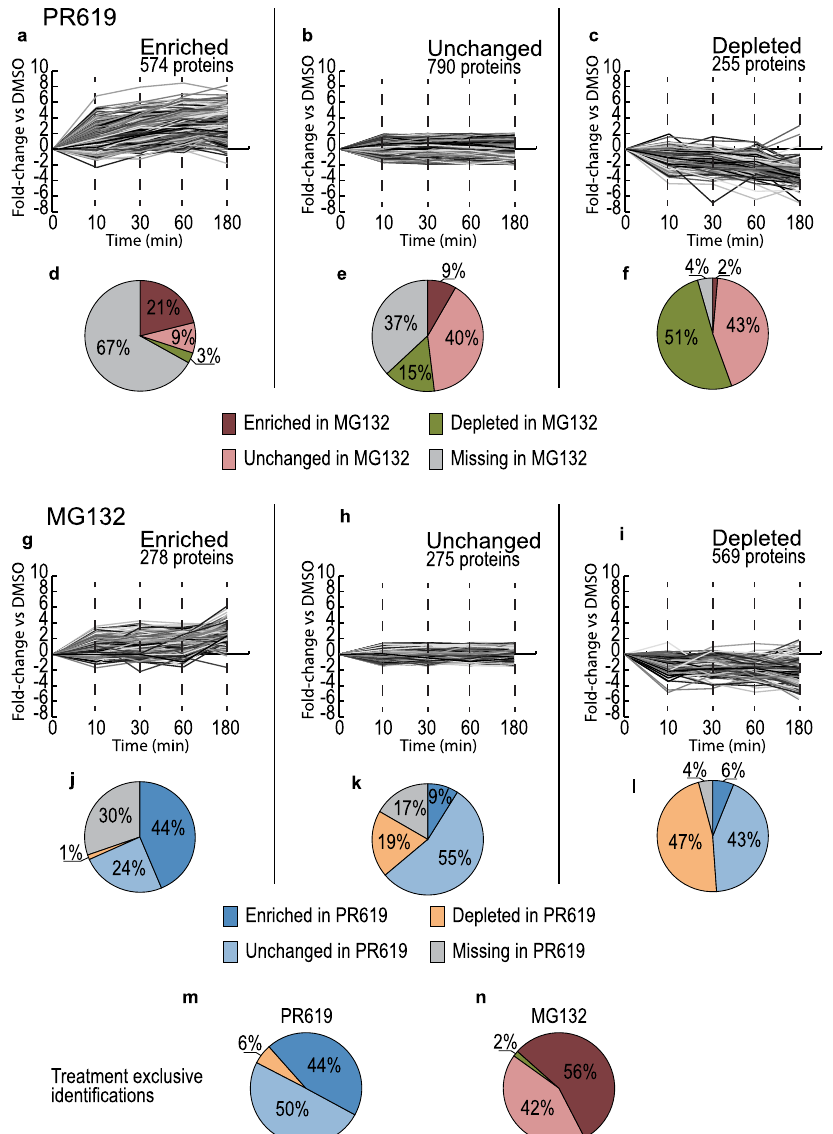
Fig. 3 Large pools of His10-Ub substrates exclusively identi fi ed in DUB or proteasome-inhibited samples. a – c Dynamics of His10-Ub substrates identi fi ed in PR619-treated samples grouped based on their fold-change vs DMSO (log2), “ Enriched ” (>twofold enrichment) ( a ), “ Unchanged ” (<twofold enrichment and <twofold depletion) ( b ) and “ Depleted ” (>twofold depletion) ( c ). d – f The His10-Ub groups in PR619-treated samples compared to their grouping in MG132 treated samples with PR619 “ Enriched ” group distribution in d , “ Unchanged ” group distribution in e and “ Depleted ” group distribution in f . g – i Dynamics of His10-Ub substrates identi fi ed in MG132 treated samples grouped according to the same criteria with groups “ Enriched ” ( g ), “ Unchanged ” ( h ) and “ Depleted ” ( i ). j – l The His10-Ub groups in MG132 treated samples compared to their grouping in PR619-treated samples with MG132 “ Enriched ” group distribution in j , “ Unchanged ” group distribution in k and “ Depleted ” group distribution in l . m , n Group distributions of proteins exclusively identi fi ed in Dub inhibited samples ( m ) or proteasome-inhibited samples ( n ). Source data are provided as a Source Data fi